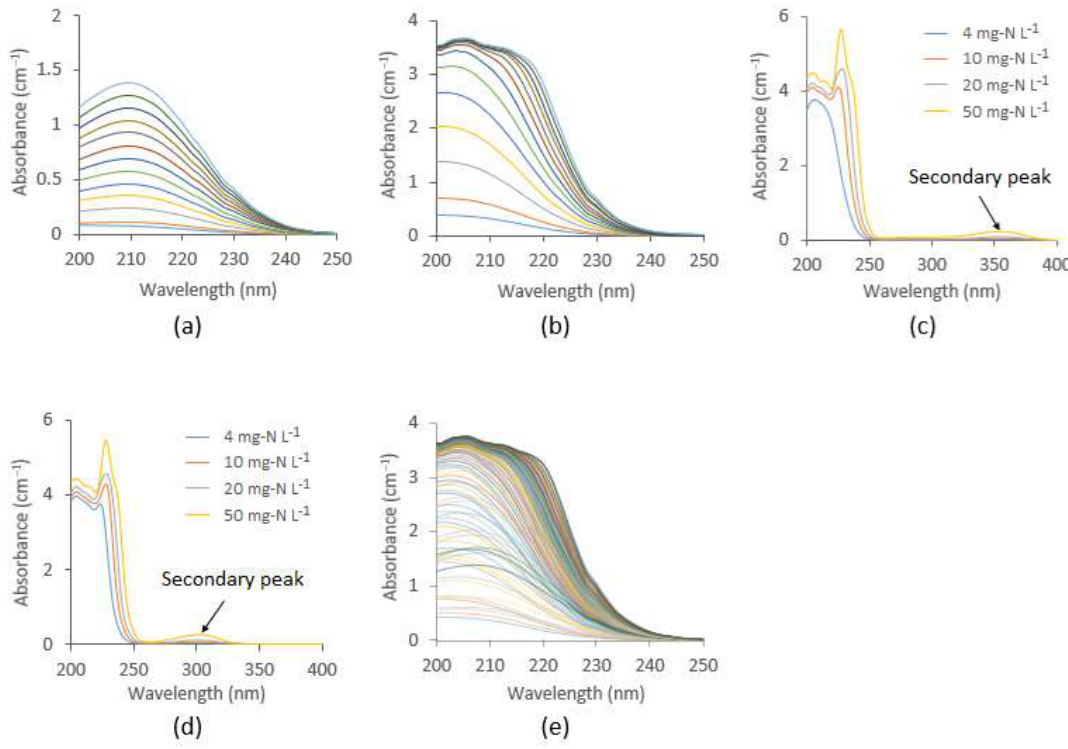
Figure 8. ( a ) Pure nitrite spectra around the primary peak region within concentration range of 0.001 mg-N L − 1 to 1.2 mg-N L − 1 ; ( b ) pure nitrate spectra for the same region at the same concentrations; ( c ) secondary peak of nitrite spectra; ( d ) secondary peak of nitrate spectra; and ( e ) pure NO x − spectra for different concentrations of nitrate and nitrite, used in developing the SVR model.